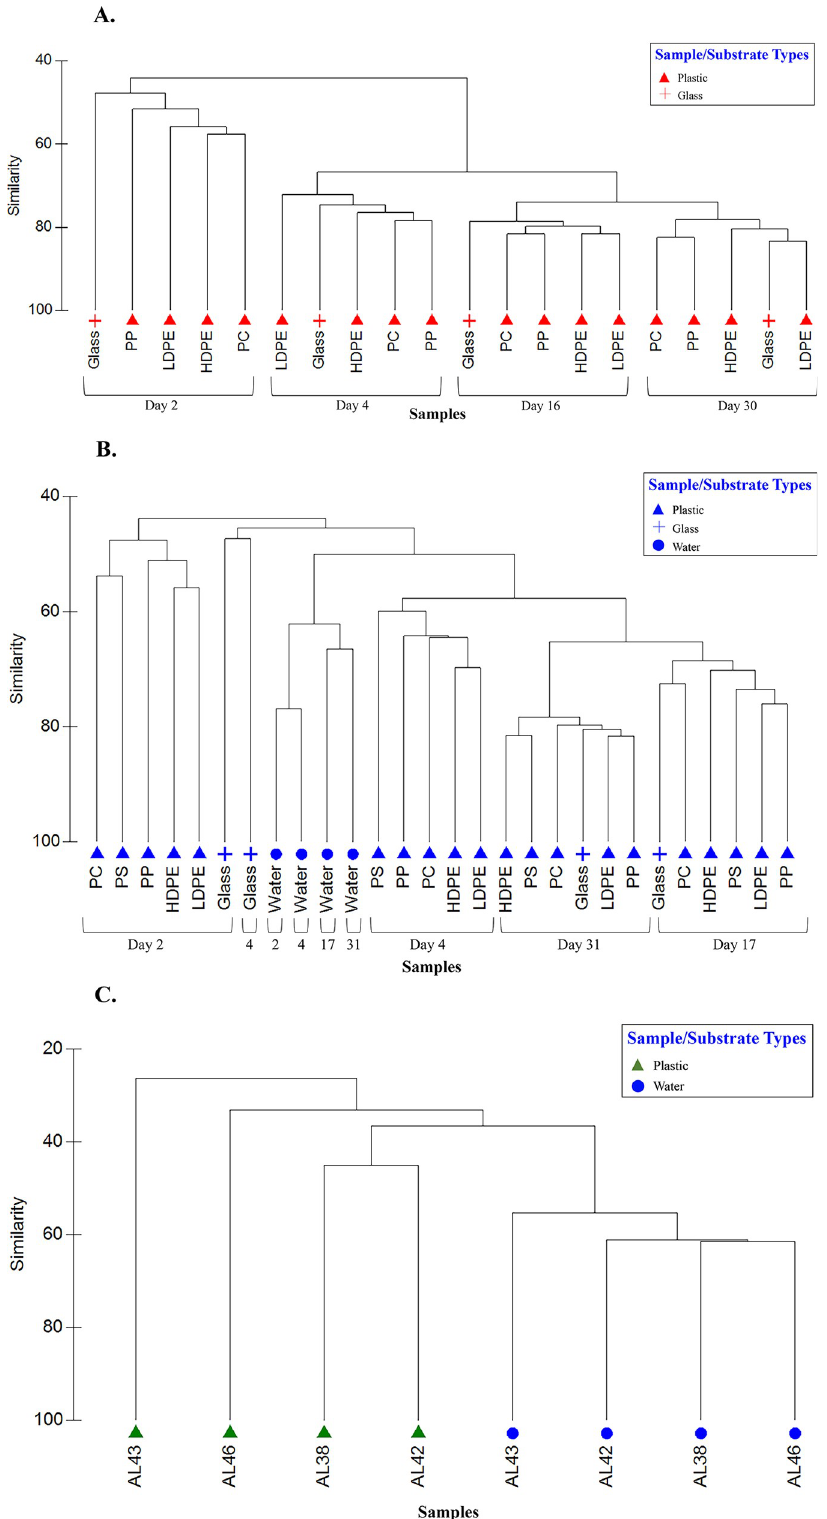
Fig 10. Hierarchical clustering dendrogram of bacterial communities showing sample relationship based on sequence data. Abundance data (Log (x+1)) was compared between samples using Bray-Curtis similarity, then